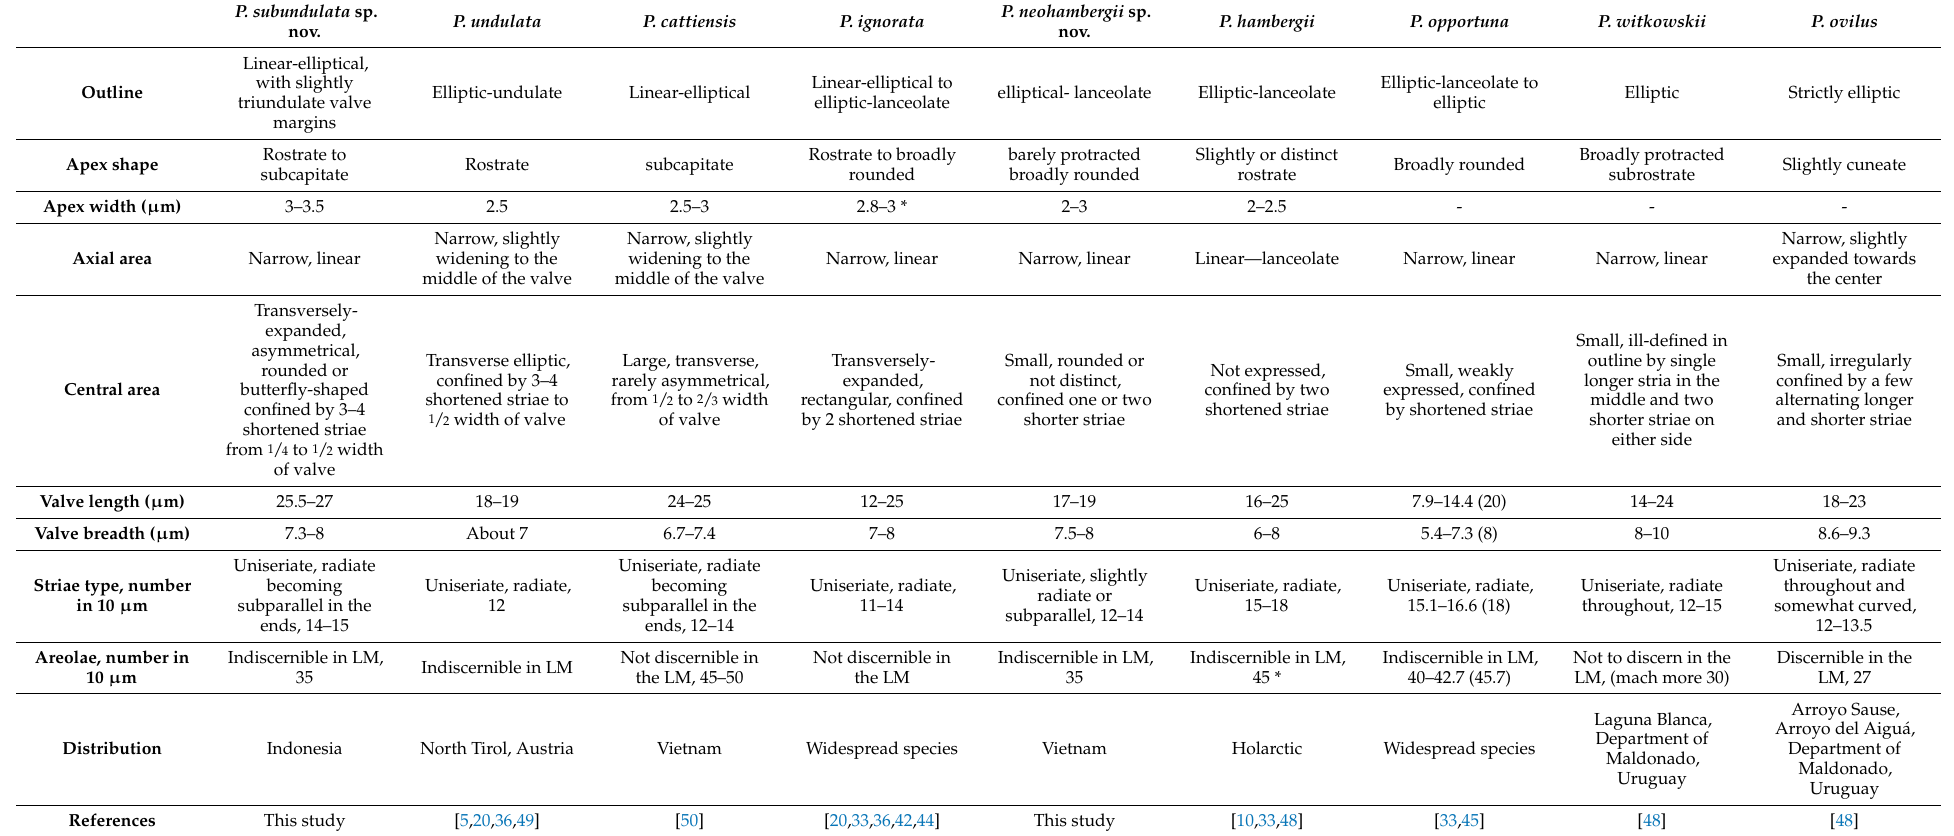
Table 3. Comparison of Placoneis subundulata sp. nov. and Placoneis neohambergii sp. nov. with similar